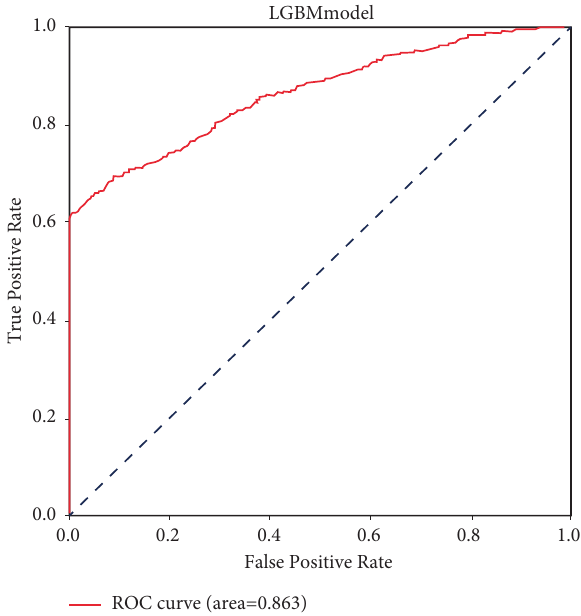
Figure 6: ROC curve of the automatic feature group